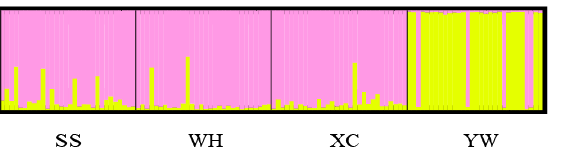
Figure 5. Structure analysis of H. molitrix populations using genotype data from 13 SSR sites. (K = 2).